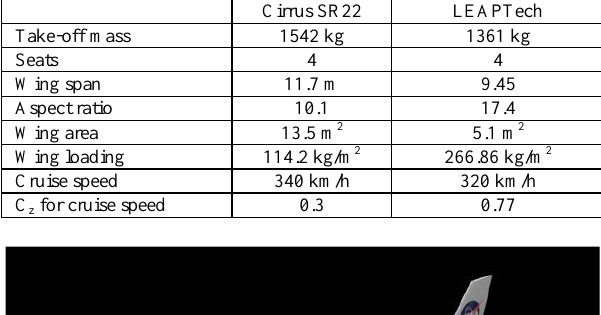
Table 1. Comparison of technical data for Cirrus and LEAPtech aircraft [2]